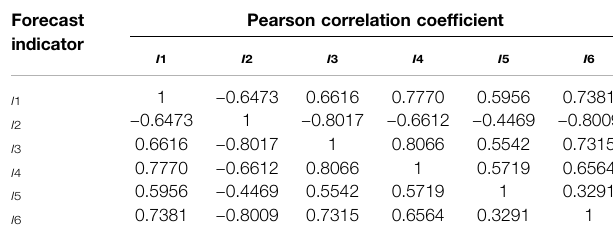
TABLE 5 | Normalized index Pearson correlation coef fi